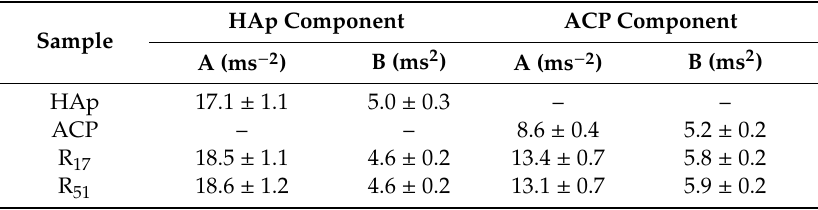
Table 4. Summary of the NMR parameters of the 31 P double-quantum (DQ)-filtered HETCOR spectra acquired for model compounds and selected human dentin